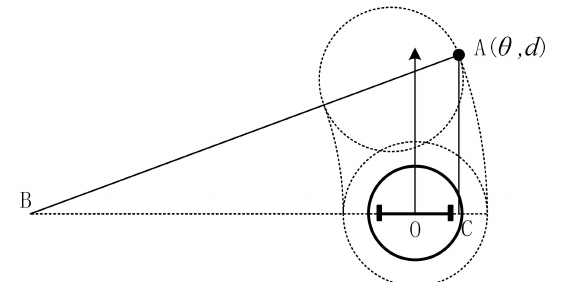
Figure 9. The robot passes by the left side of point-like obstacle A.